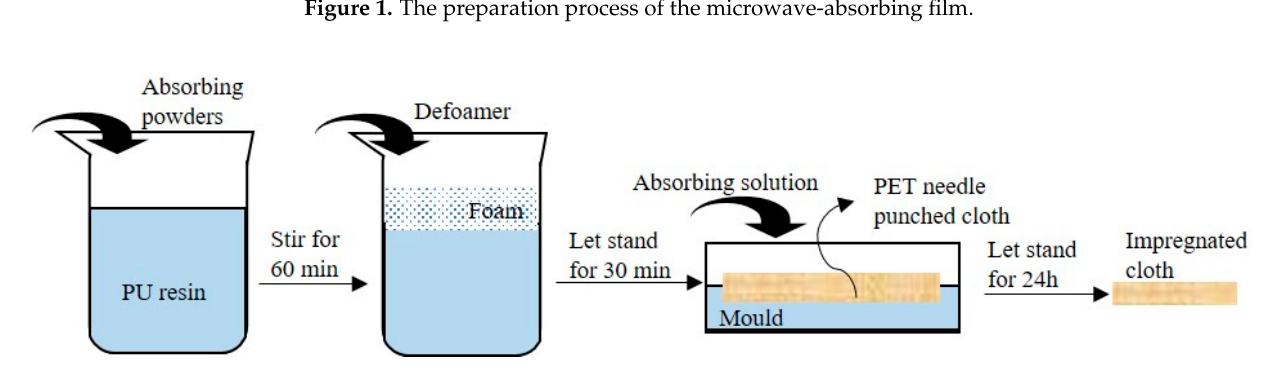
Figure 2. Preparation process of microwave-absorbing impregnated nonwoven fabric.